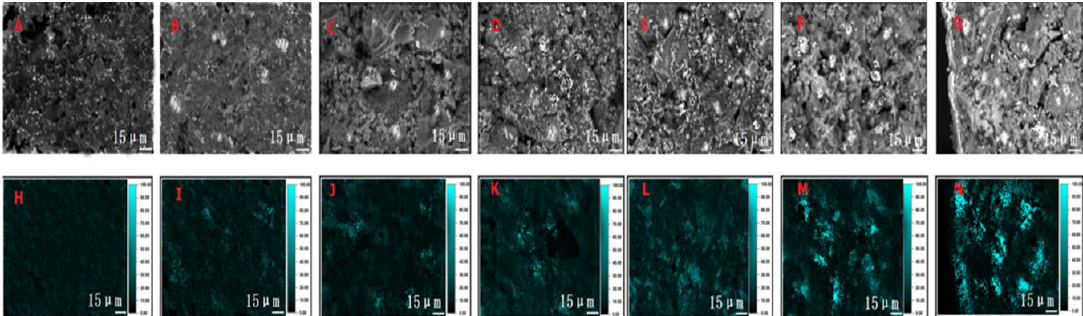
Figure 4. SEM images of the catalyst samples: ( A ) D-Fe0.8-M; ( B ) K-Fe0.8-M; ( C ) K-Fe0.8-O; ( D )